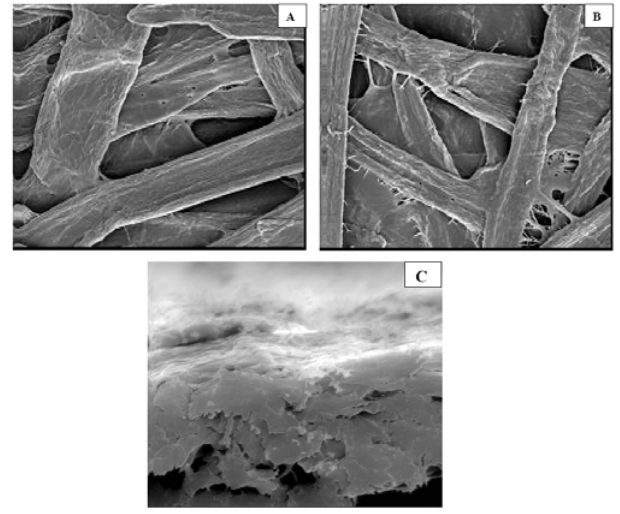
Fig. 7 SEM micrographs (1000 x) of pyrrole plasma treated papers (A: untretaed paper, B: 50 W, C: Cross section of B